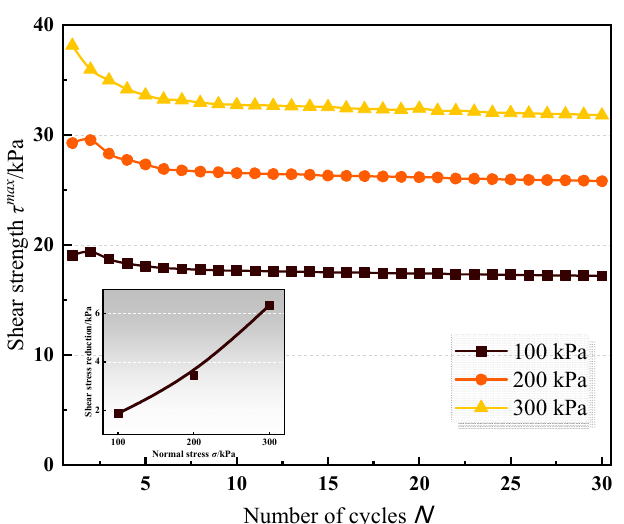
Figure 8. Shear strength–number of cycles curve under different normal stress levels. The stress ratio–cycle number curve in Figure 9 shows that normal stress significantly impacted the interface cyclic weakening profile. With the increase in normal stress, the weakening degree increased. The trend agreed with those reported by Oumarou et al. (2005) and Feng et al. (2018) [21,22]. Figure 9. Stress ratio–number of cycles curve under different normal stress levels. To more clearly capture the relationship between this weakening phenomenon and the number of cycles, the shear strength weakening coefficient S n τ was further adopted based on the stress ratio D τ to characterize the cumulative weakening degree of the first n cycles. The representative weakening coefficients S 5 τ , S 10 τ , S 15 τ , S 20 τ , S 25 τ , and S 30 τ under the three normal stresses were calculated. The results are shown in Figure 9. The maximum weakening coefficients S 30 τ under the three normal stresses were 9.84%, 11.84%, and 16.6%, respectively.